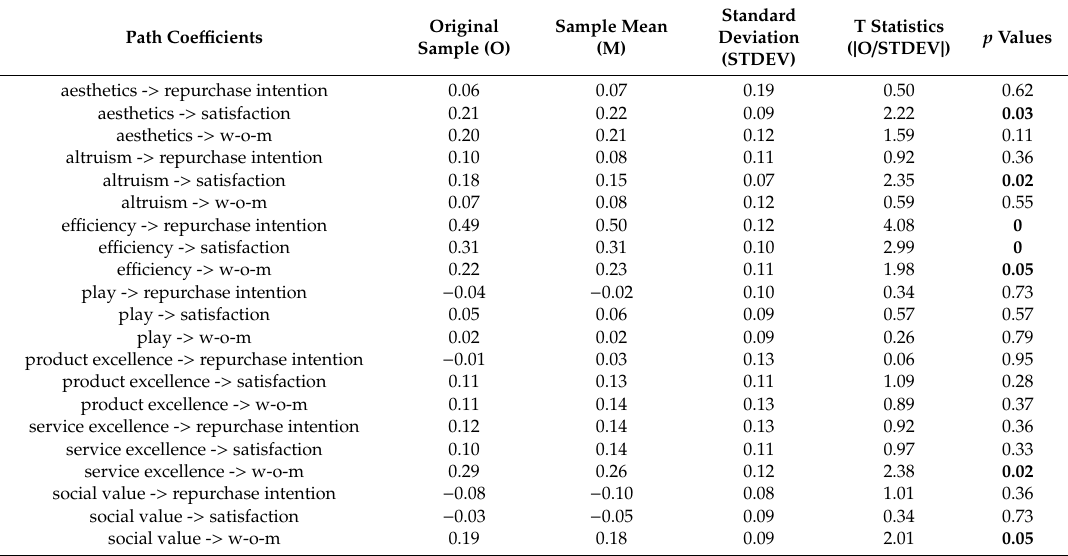
Table 8. Bootstrapping results of total e ff